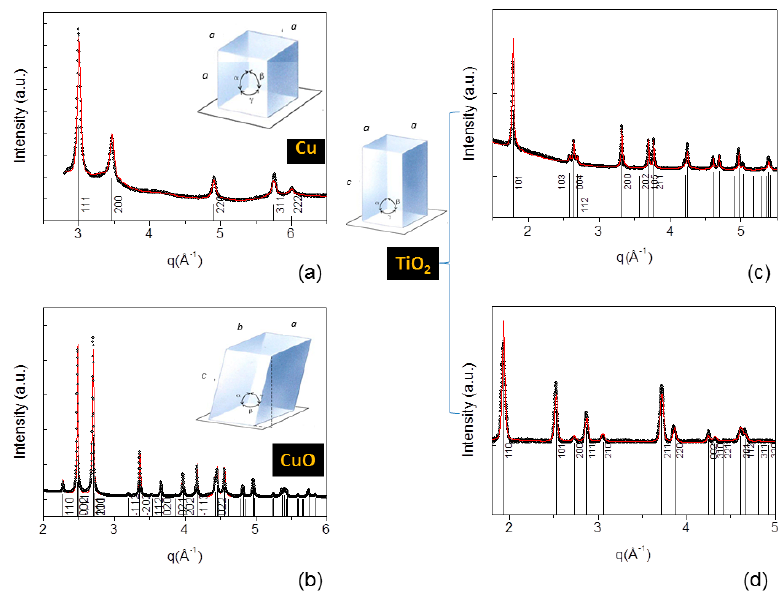
Figure 6. X-ray powder diffraction profiles measured from cubic copper ( a ) monoclinic tenorite; ( b ) tetragonal anatase; ( c ) and rutile; ( d ) nanocrystals. The dotted curves represent the experimental data, the red lines the fitted profiles. Experiments were performed by using a Bruker D8-Discover diffractometer, in reflection mode, with Cu K α 1 radiation, i.e., λ = 1.540562 Å.